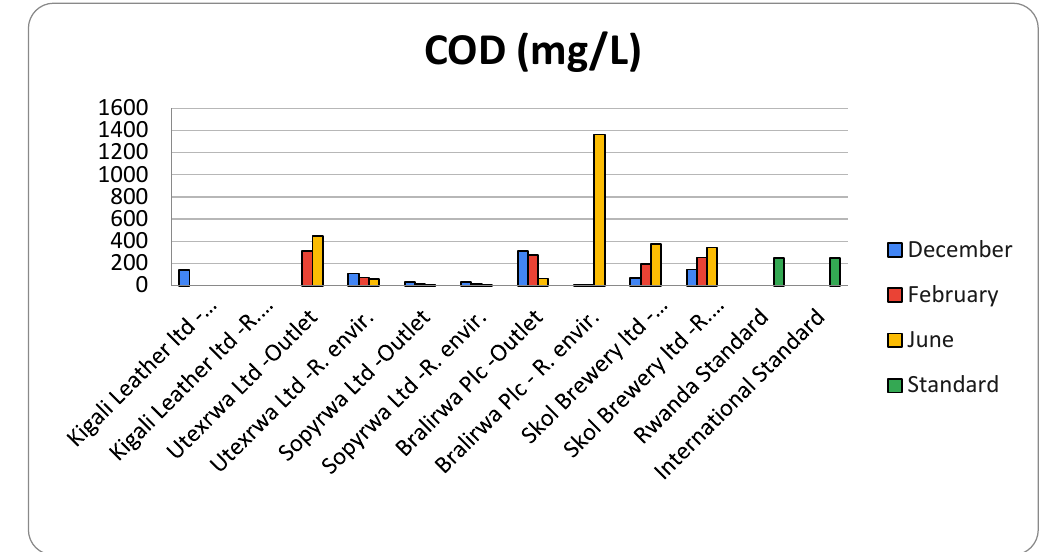
Figure 4. COD (mg/L) distribution per site.